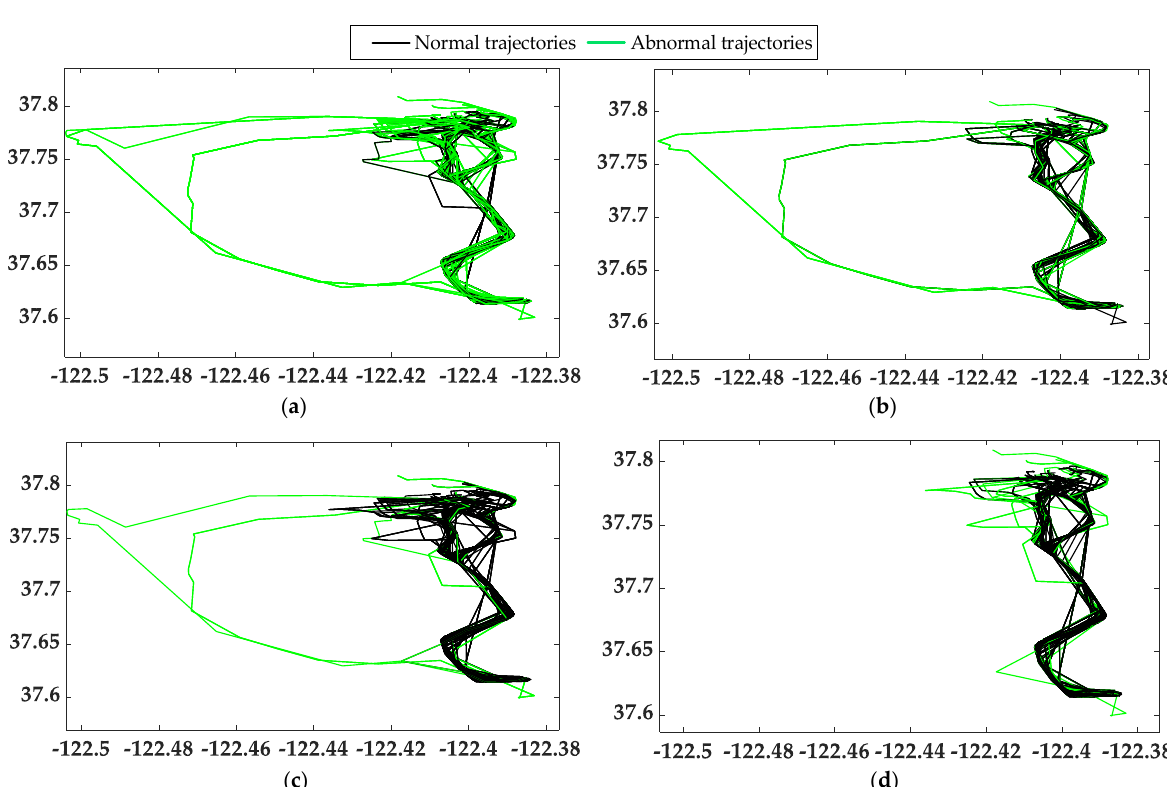
Figure 12. Visualization of iBAT results: ( a ) T-1; ( b ) T-2; ( c ) T-3; ( d ) T-4.